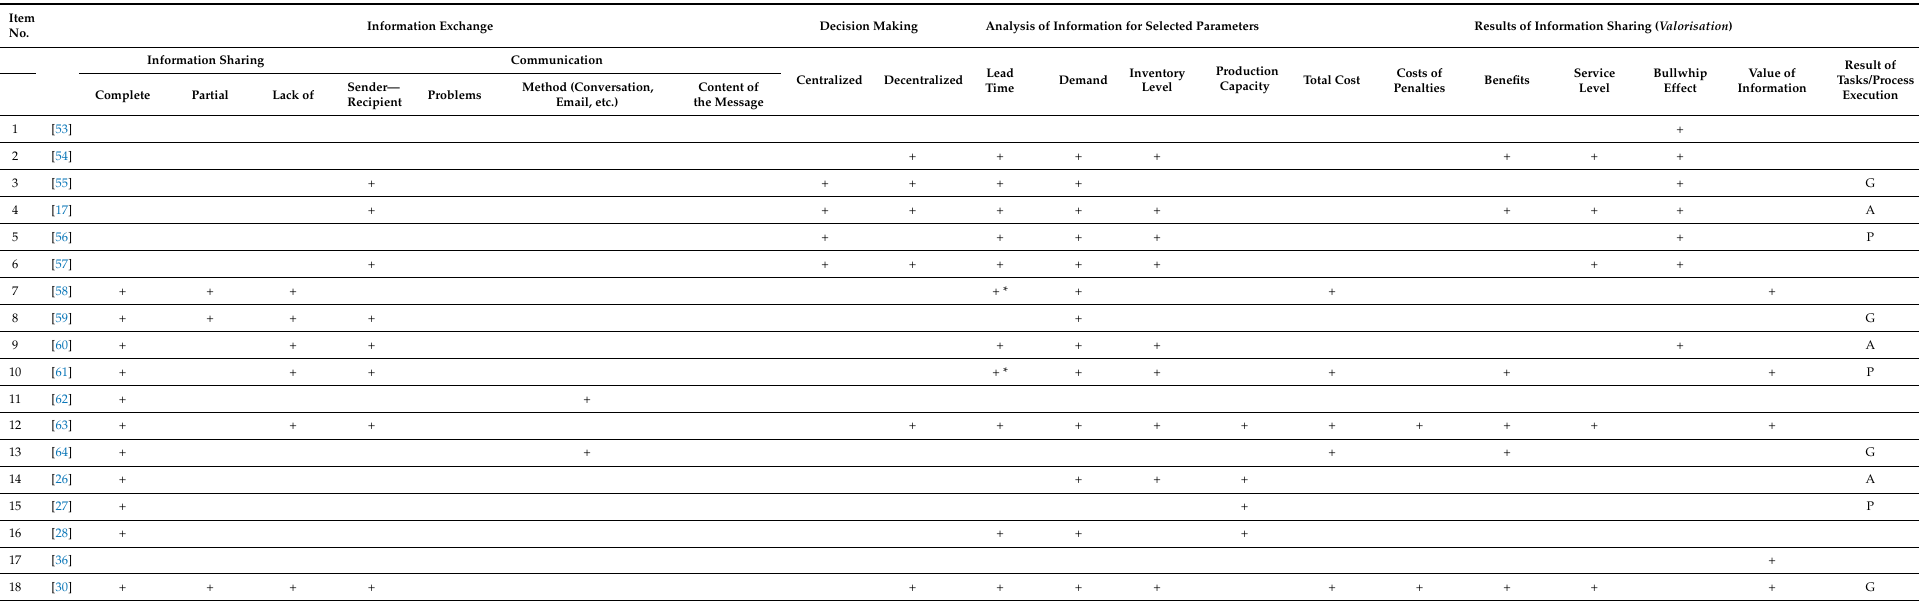
Table A1. Summary of the literature review of the issue of information flow in logistic